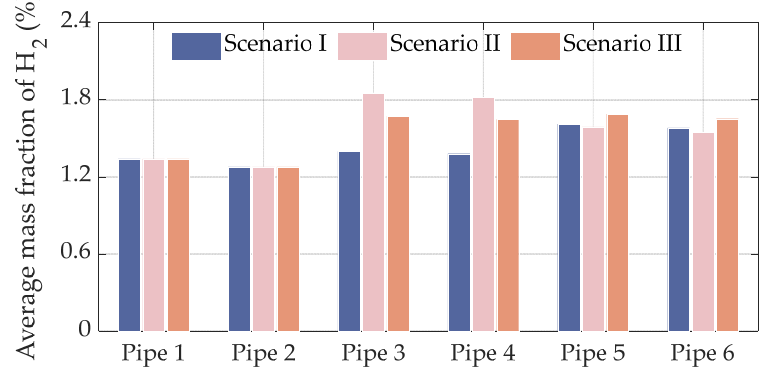
Figure 20. The average mass fraction of hydrogen in the six pipelines under 3 scenarios.